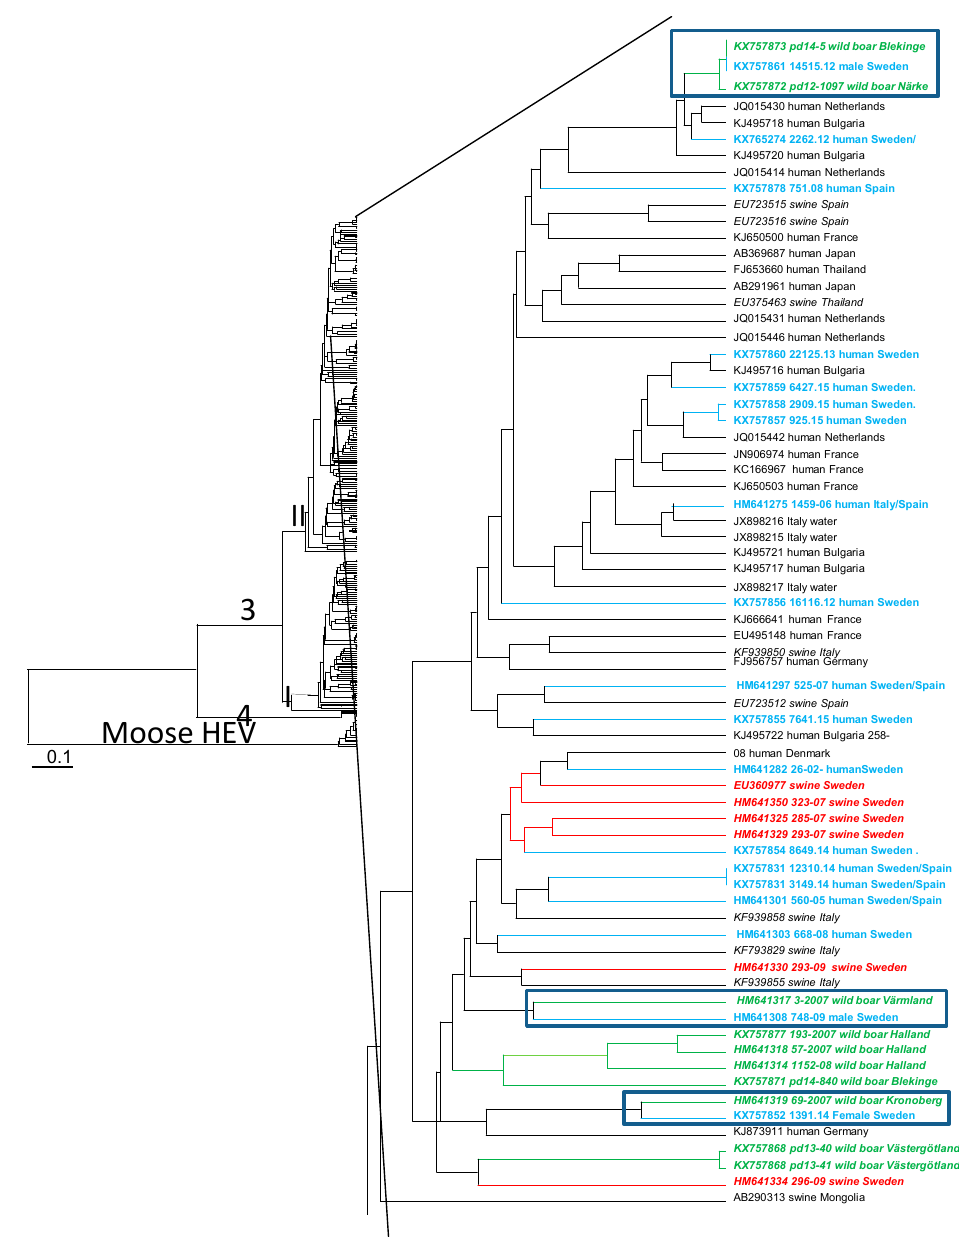
Figure 1. Unweight pair ‐ group method using arithmetic averages (UPGMA) phylogenetic tree formed by 335 nucleotides of partial open reading frame 1 (ORF1) of 361 HEV sequences representing HEV3, HEV4, and moose HEV from this study and obtained from GenBank. The genotypes of the strains are indicated on the branches of the tree. The branch formed by HEV moose strains is indicated. A branch within the 3II clade [37] is enlarged. Accession number or strain designation of the strains in this study together with origin and host of the strains are given at the nodes. The three clades formed by strains from endemic human cases and strains from Swedish wild boar are boxed. Strains from humans infected in Sweden are colored blue, strains from Swedish pigs are colored red, and strains from Swedish wild boar are colored green.